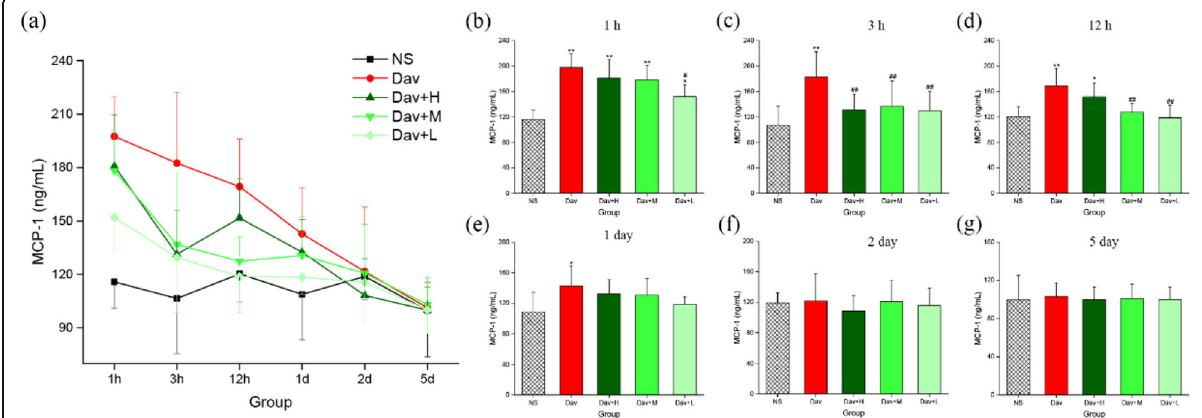
Fig. 10 Effects of Phellodendri Chinensis Cortex Carbonisata-carbon dots (PCCC-CDs) on MCP-1 level in the kidney tissue. a MCP-1 level changes in 1 h, 3 h, 12 h, 1 day, 2 days, and 5 days. MCP-1 levels in ( b ) 1 h, ( c ) 3 h, ( d ) 12 h, ( e ) 1 day, ( f ) 2 days, and ( g ) 5 days. Mice were treated with normal saline (NS), D.acutus venom (Dav, 1 mg/kg) and high (H), medium (M), and low (L) doses of PCCC-CDs + Dav (1 mg/kg). Data are represented as mean ± SD of six animals of each group. * p < 0.05 and ** p < 0.01 compared with control group treated with normal saline